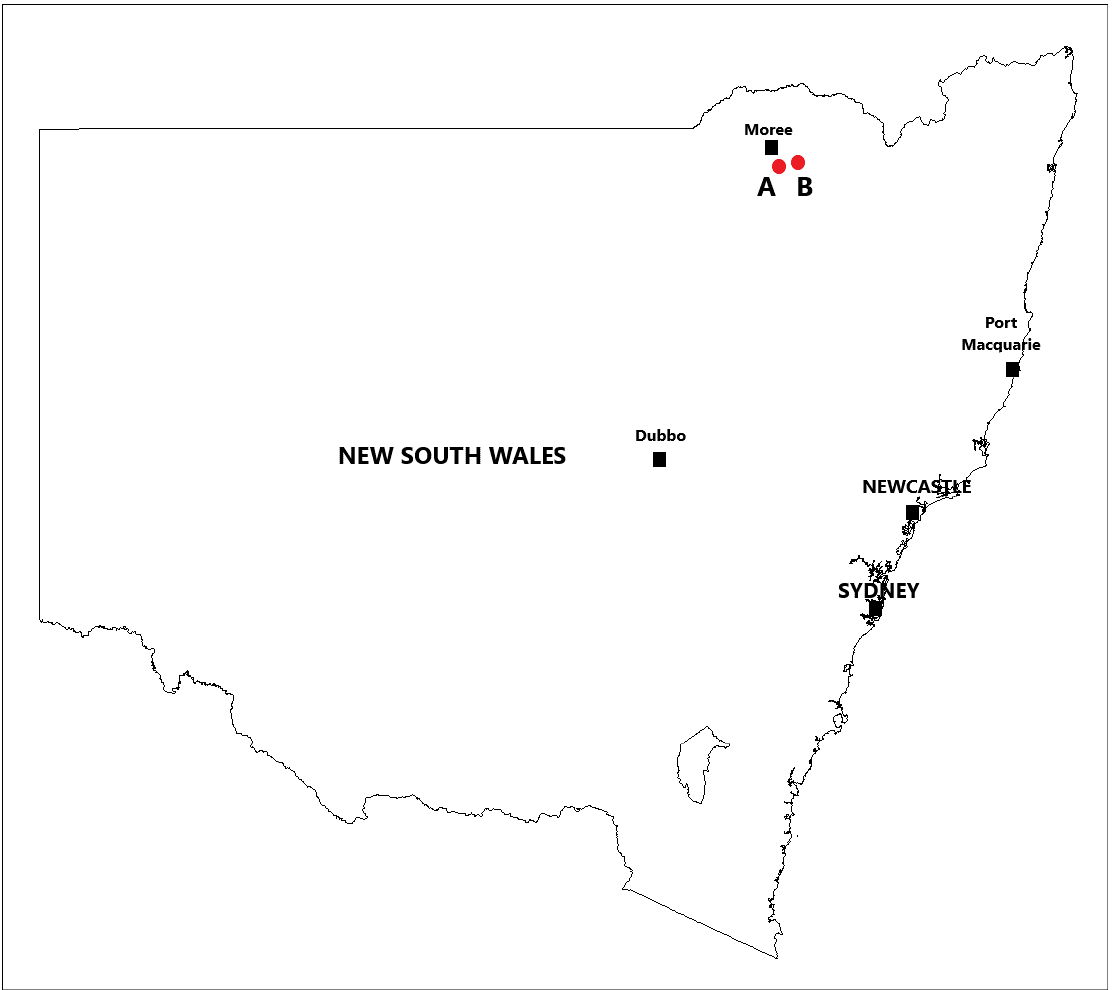
Figure 1. Intact plant and cut stump trial locations at Moree, NSW; (A) first round of trials (2018) and (B) second round of trials (2019).